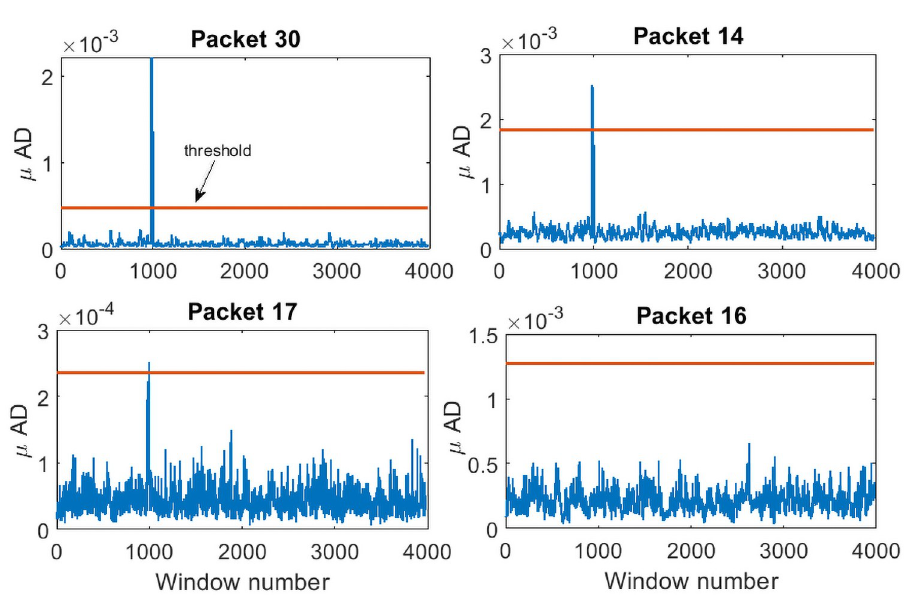
Fig 5. μAD in the highlighted packets. There is a sudden increase in the μAD in certain packets (30, 14 and 17) while in other packets (16 is shown in the figure, but it holds for the rest of the packets), μAD is always below the threshold.